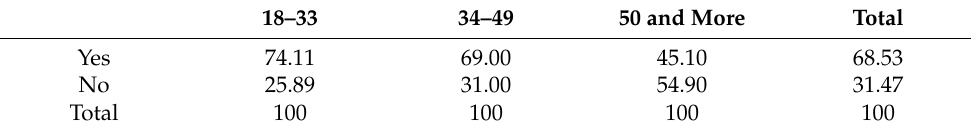
Table 10. Declared plans to improve competences on their own vs. age in % (N =